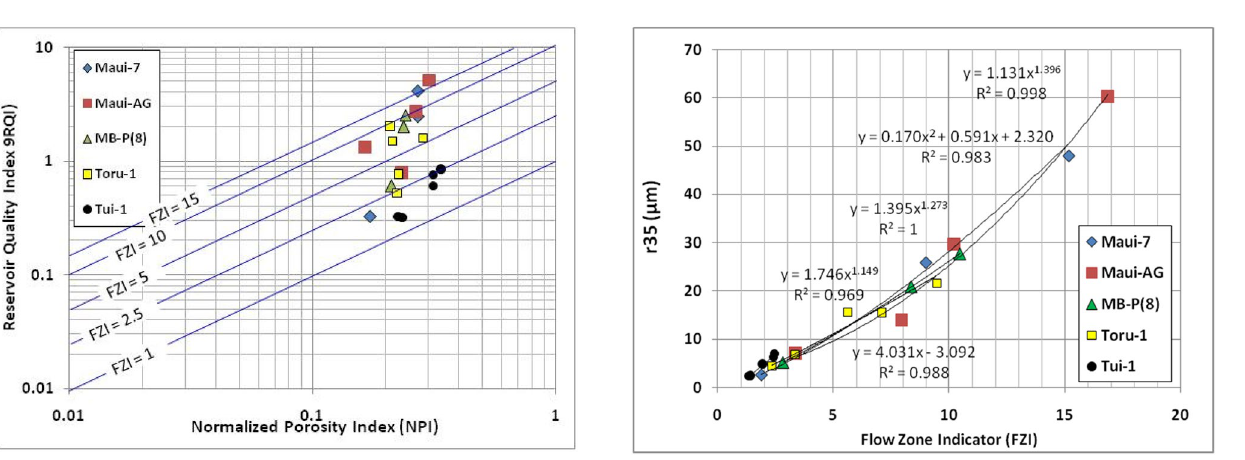
Fig. 12 Plotting of pore throat radii (r35) versus Flow Zone Indicator